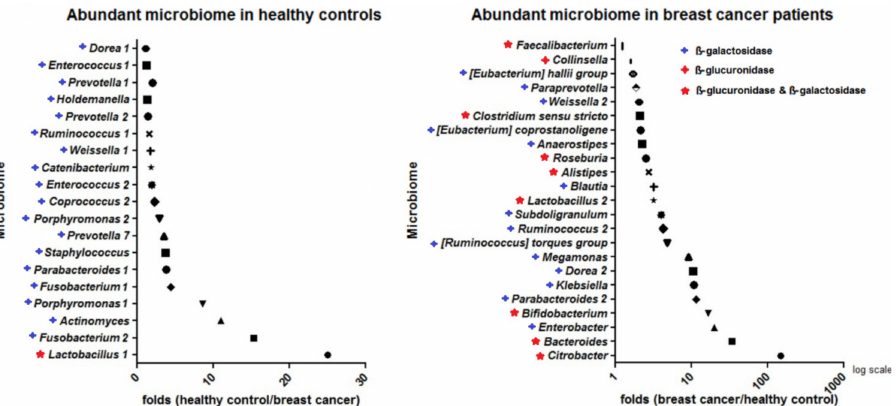
Figure 2. Comparison between blood microbiome composition of healthy controls and breast cancer patients. Three types of symbols indicate microbiota producing β − glucuronidase and/or β − galactosidase. As the data were acquired from sequencing at the genus level, when micro- biota belonged to the same genus but to different species, the microbes with the same names were numbered